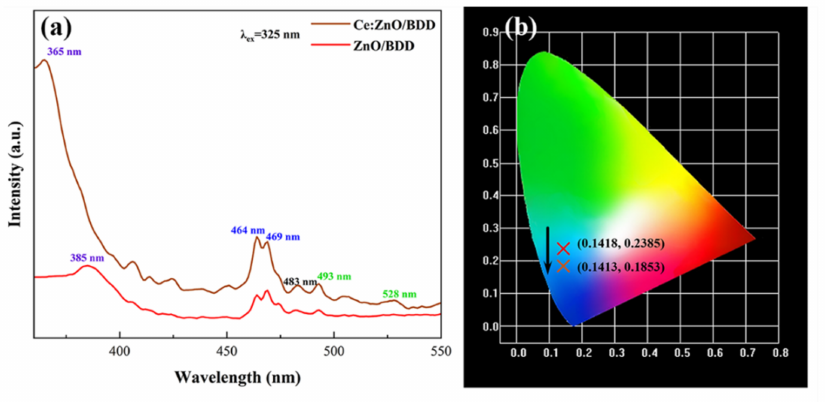
Figure 3. ( a ) PL spectra and ( b ) standard CIE color graphs of the n-ZnO/p-BDD and n-Ce:ZnO NL/p-BDD heterojunctions.